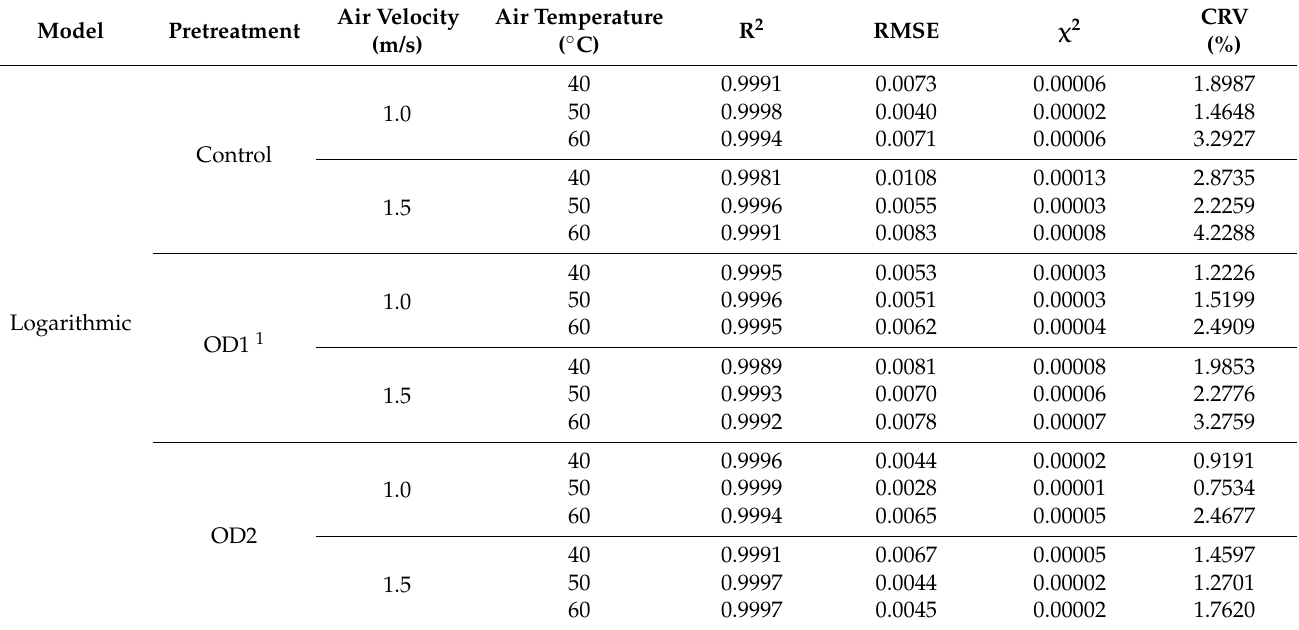
Table 5. Statistical analysis of logarithmic model used to describe the kinetics of hot air drying of fresh and osmotically- pretreated apricot halves.